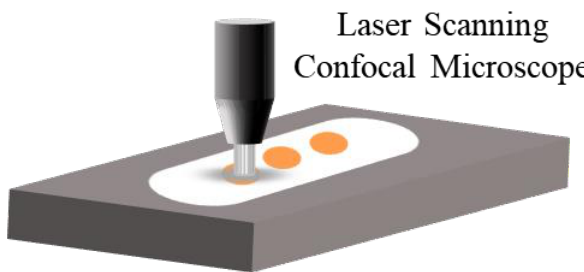
Figure 3. Measurement method of polished surface by LSCM.